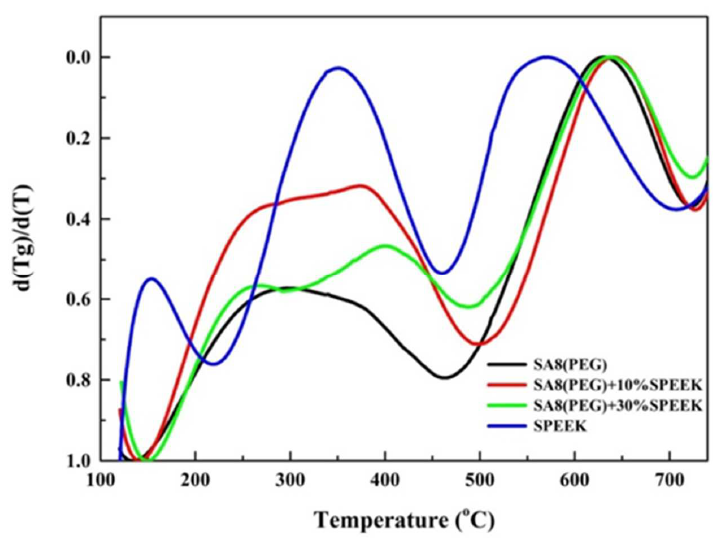
Figure 16. DTG diagram of sulfonated polymers [25–27].